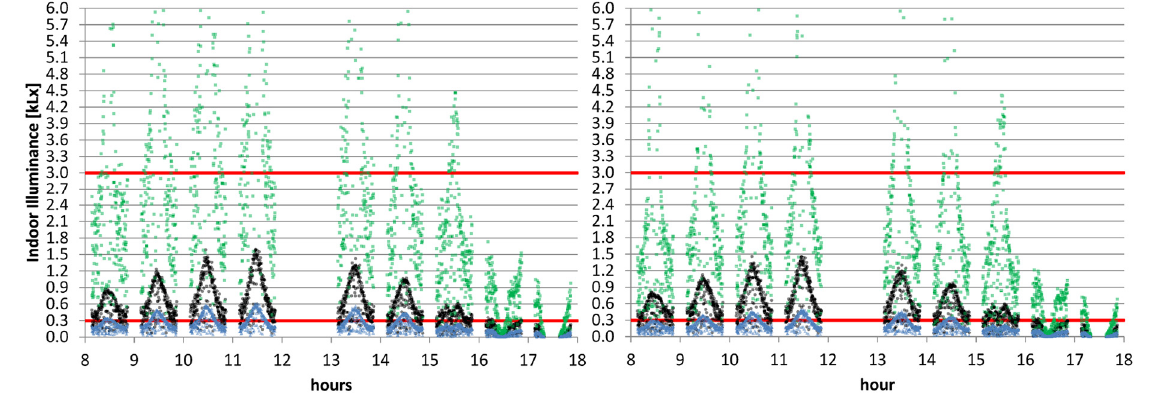
Figure 9. Distribution of indoor illuminance values for sensor points two (blue), five (black), and eight (green): ( a ) Scenario “no shading”; ( b ) Optimized